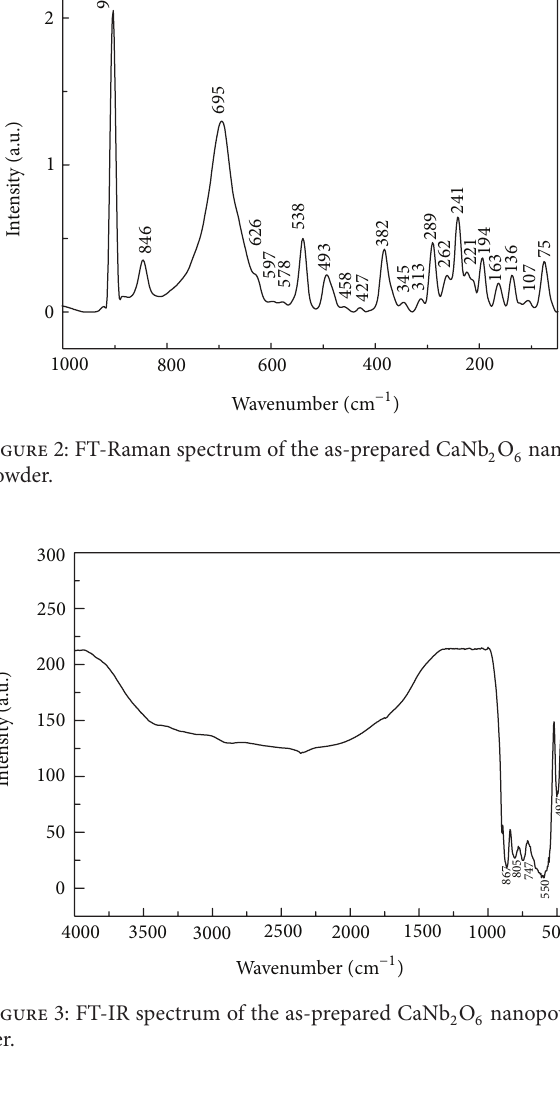
O and their band 2 6